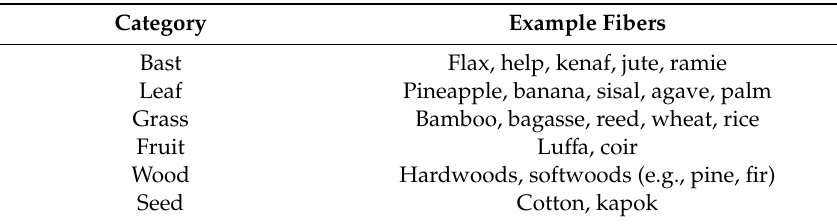
Table 6. Categories of plant-based fibers